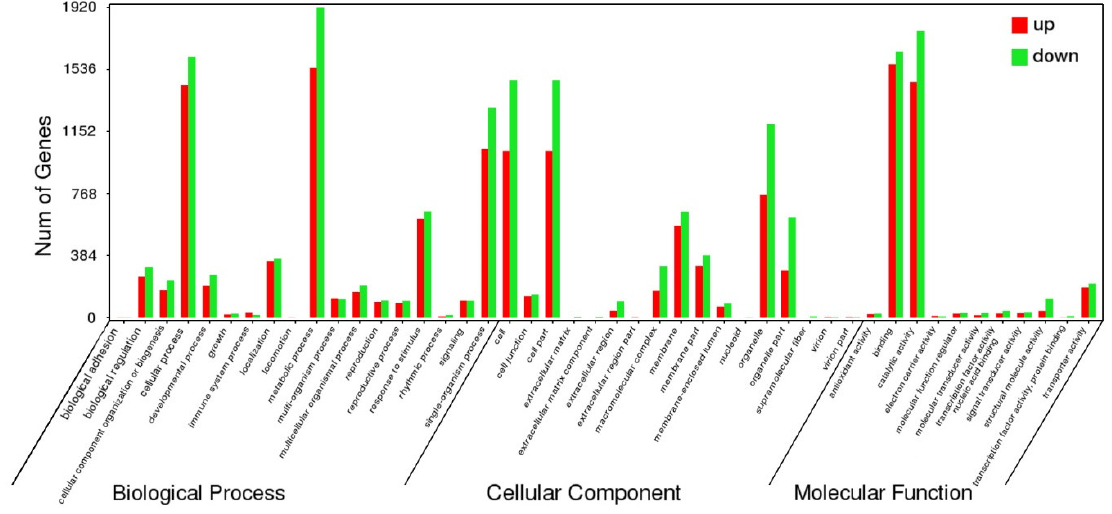
Figure 7. Gene Ontology (GO) enrichment classification of differentially expressed genes (DEGs) between drought-treated P. ostii and the control. Red histograms represent upregulated DEGs, green histograms represent downregulated DEGs.